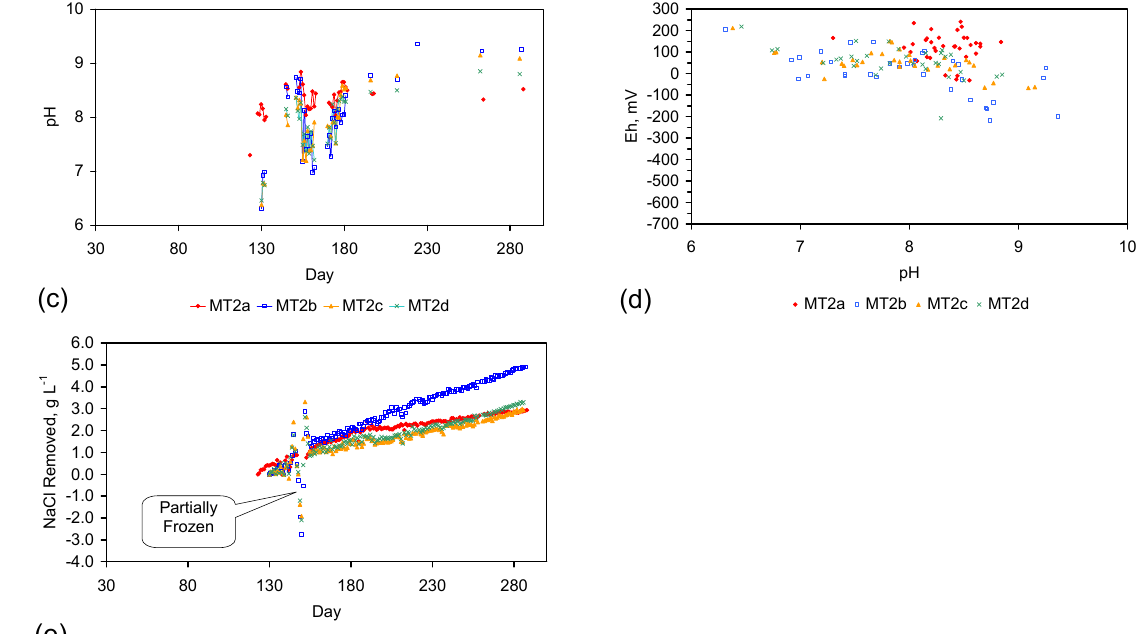
Figure C14. ( a ) EC vs. day; ( b ) Eh vs. day; ( c ) pH vs. day; ( d ) pH vs. Eh; ( e ) NaCl Removed (calculated from EC and residual water volume) vs. day. MT2a = 79.5 g·L − 1 ; MT2b = 121.3